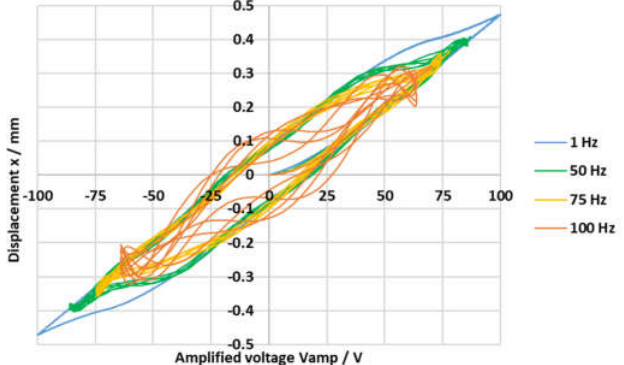
Figure 5. Simulated hysteresis curves for model NAC2645 according to different input frequencies of V c (sine wave from −5 V to +5 V).